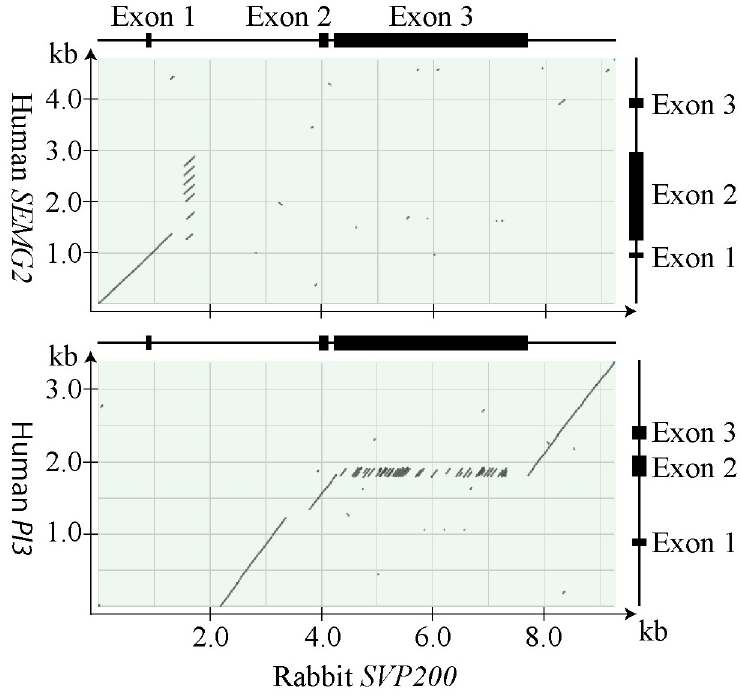
Fig 7. Homology of rabbit SVP200 and human SEMG2 and PI3 . The dotplots illustrate the results of BLAST alignments, showing homology with SEMG2 in the 5’ end and PI3 in the 3’ end of SVP200 . The lines at the top and to the right of the dotplots illustrate genes, with boxes depicting the location of